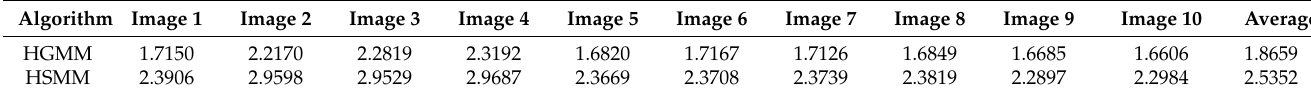
Table 6. Efficiency performance of the HGMM-GD and HSMM